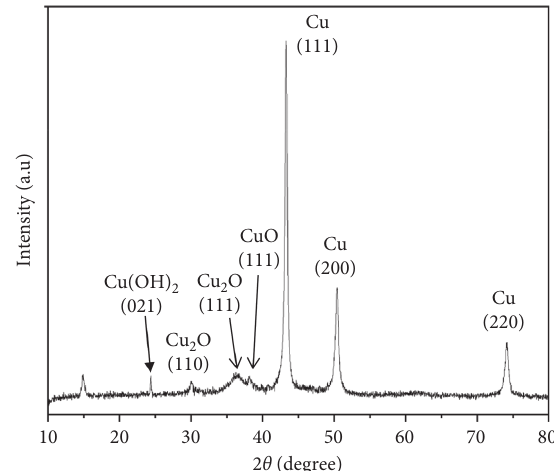
Figure 4: XRD spectrum of CuNPs centrifuged after 90min of